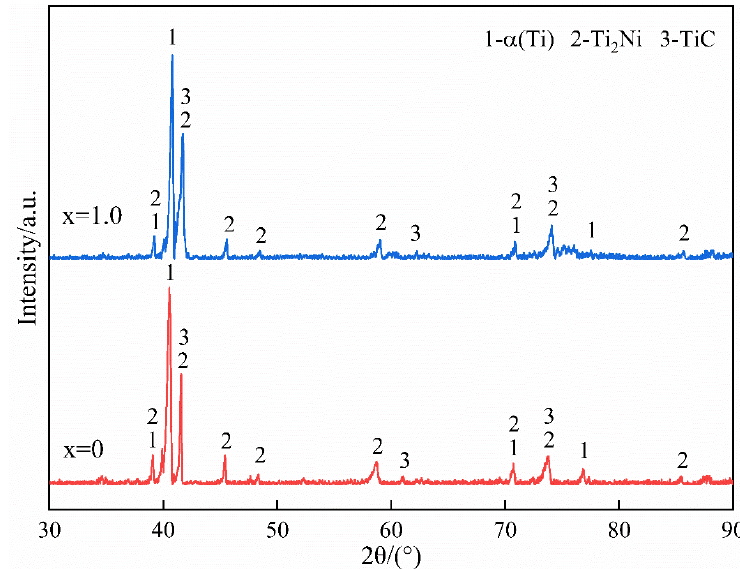
Figure 2. XRD patterns of the coatings. Table 1. The mixing enthalpy (ΔH mix , KJ·mol −1 ) for each pair of elements adapted from [44].